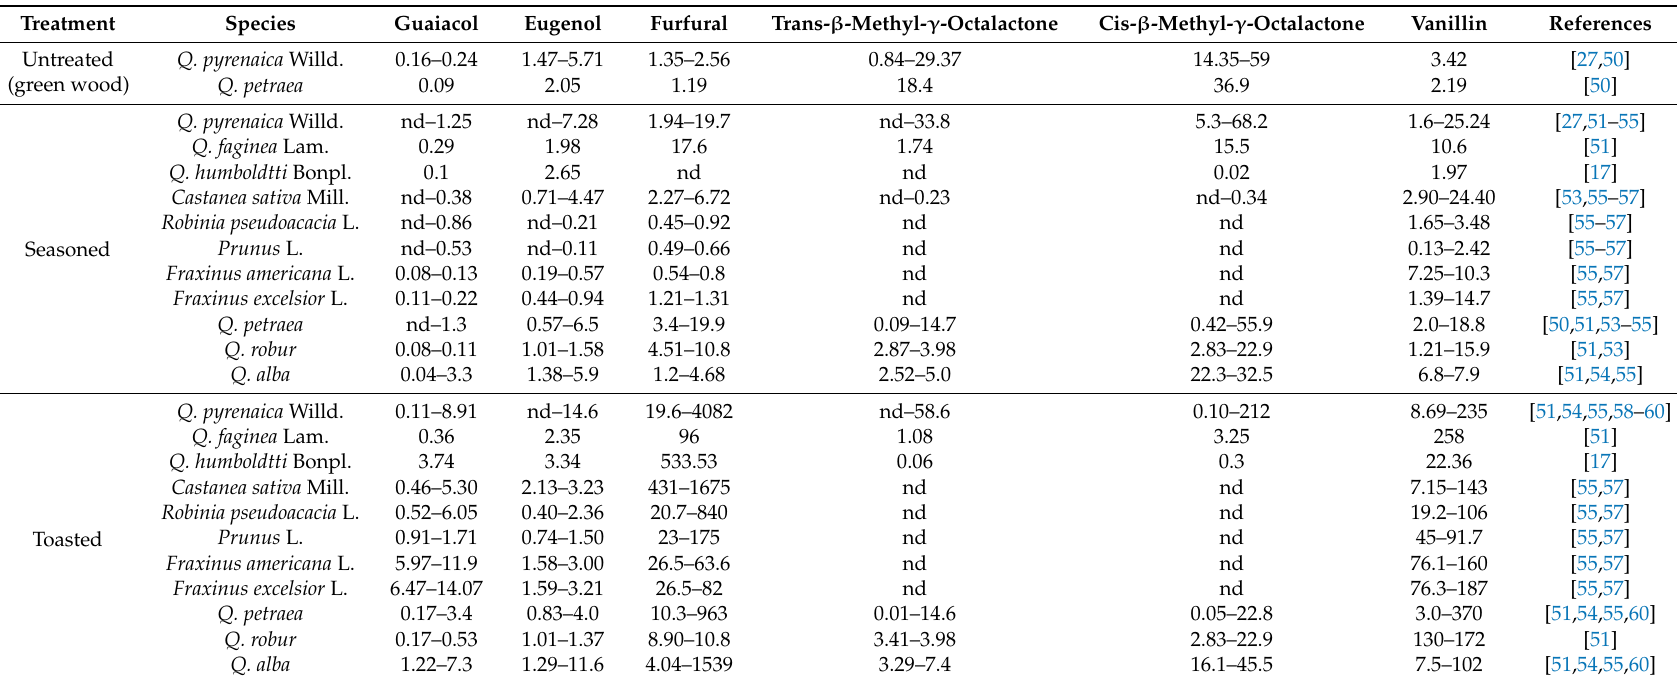
Table 2. The range of volatile compounds expressed as µ g/g wood found in green, seasoned, and toasted